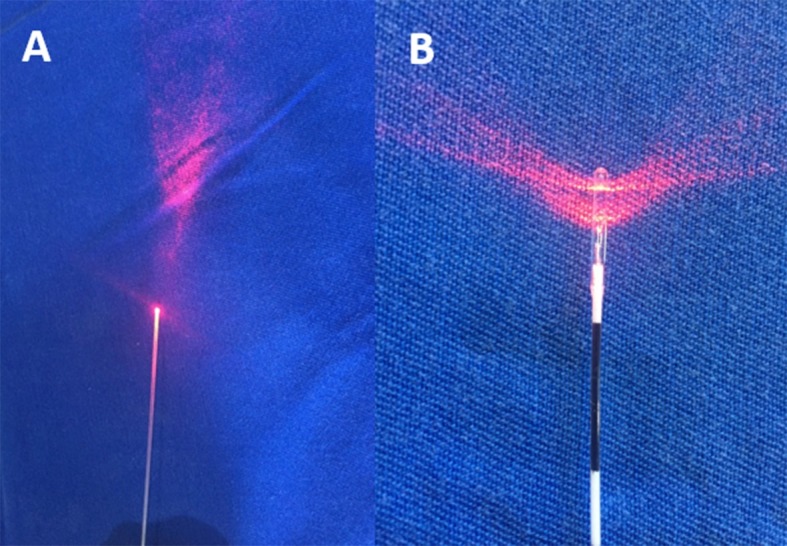
(A) Conventional (bare) fiber; (B) Double radial fiber.